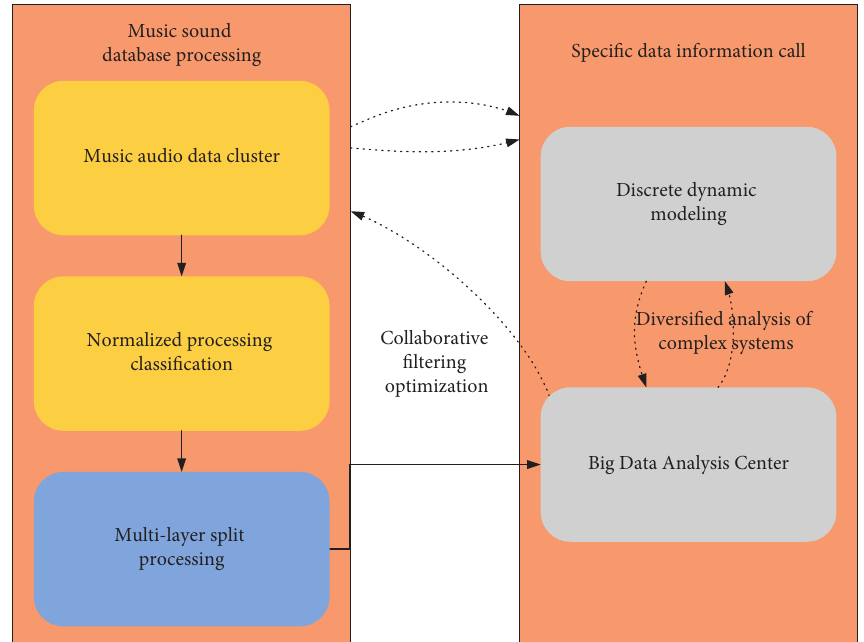
Figure 1: Data analysis process of the discrete dynamic modeling method based on collaborative filtering algorithm in the database.